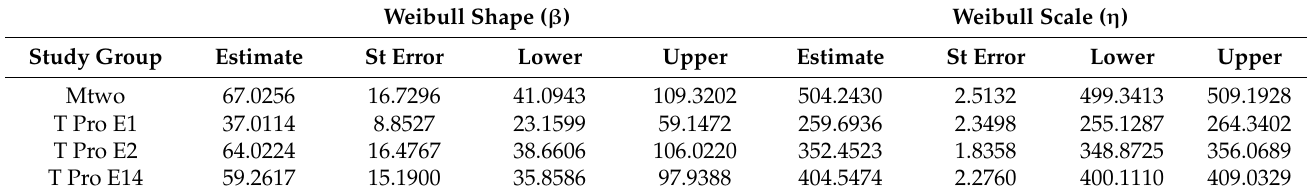
Table 3. Weibull statistics of time to failure of replica-like and original brand NiTi endodontic rotary files study groups.